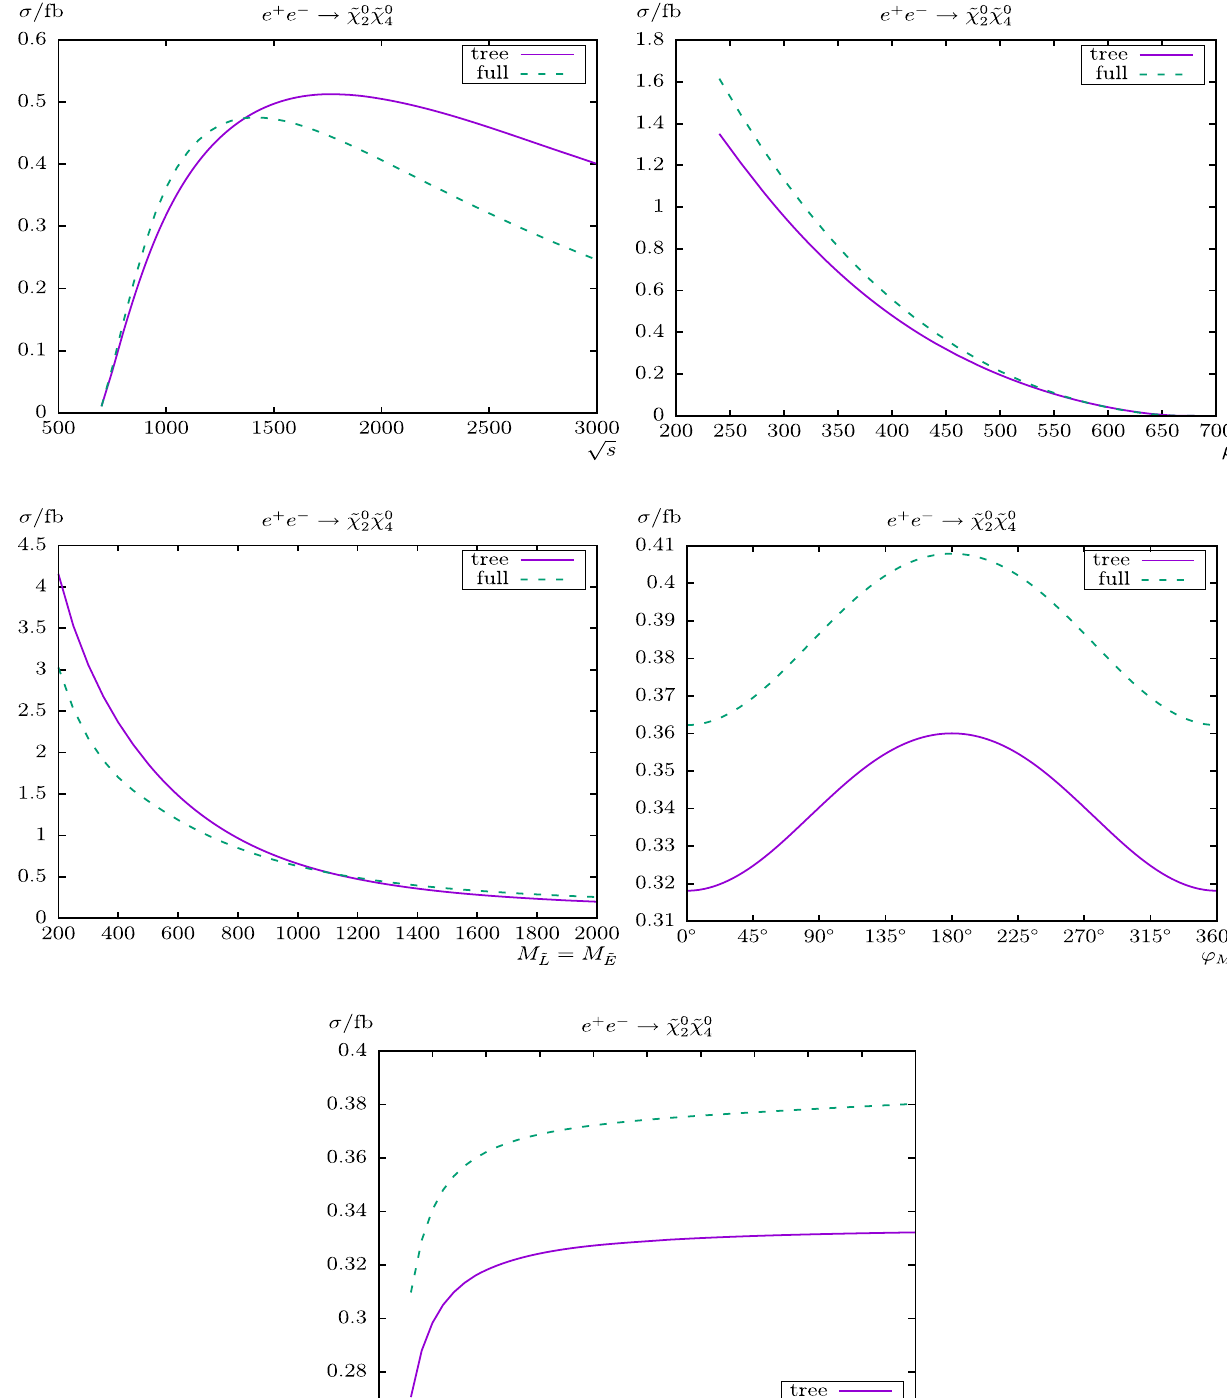
= M ˜ (left) and ϕ M (right) L E 1